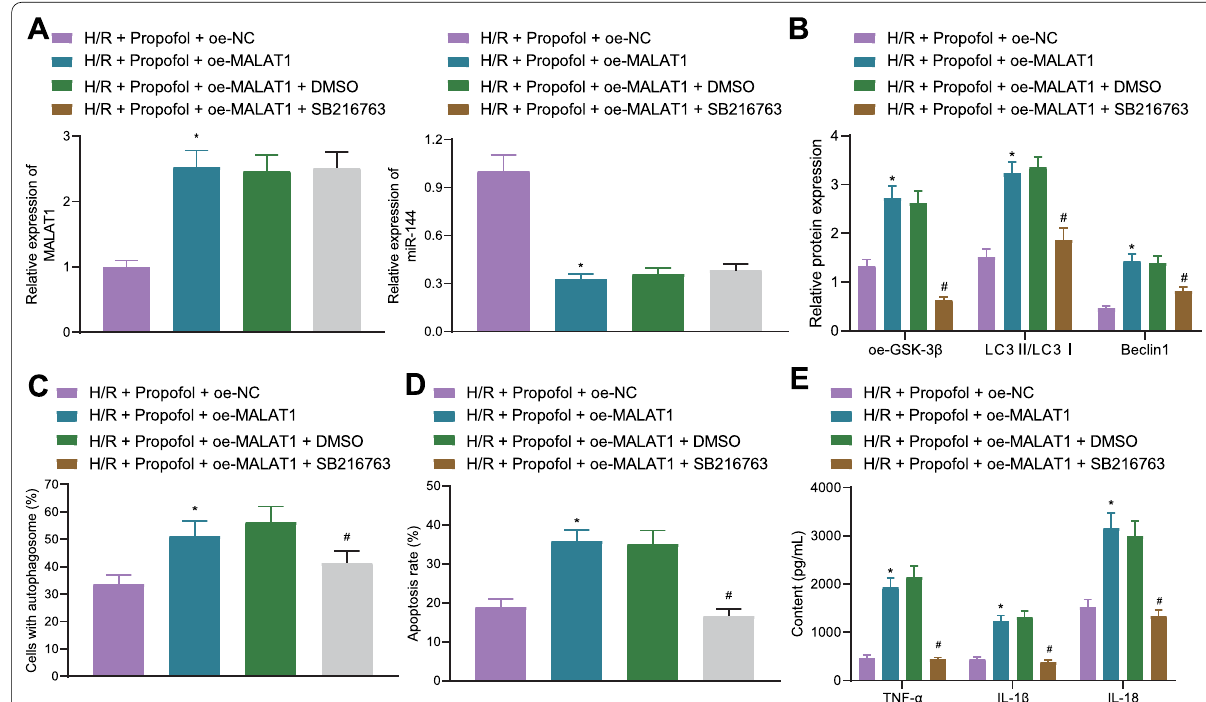
Fig. 7 Propofol alleviates I/R injury through the MALAT1/miR‑144/GSK3β axis in vitro . A Expressions of MALAT1 and miR‑144 in cells as detected by RT‑qPCR (* p < 0.05, compared with the H/R (* p < 0.05, compared with the H/R of autophagosome as determined by immunofluorescence against LC3 (* p < 0.05, compared with the